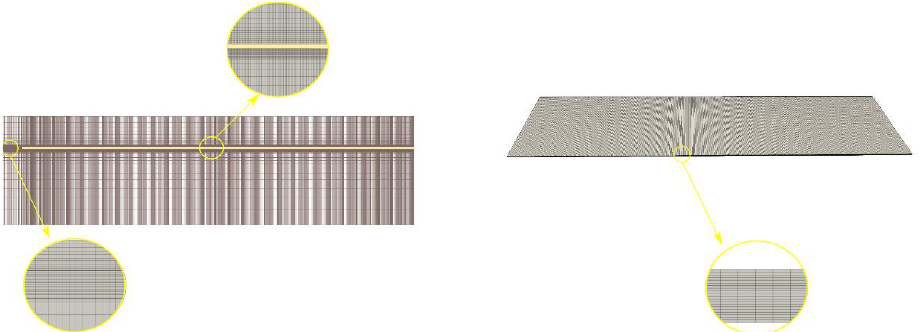
Figure 3. The mesh used to solve the wave – ice interaction in the present research. The structure of the mesh generated in the fluid domain is shown on the left, and the one related to the solid domain is shown on the right. Zoomed-in views are indicated in the circles.